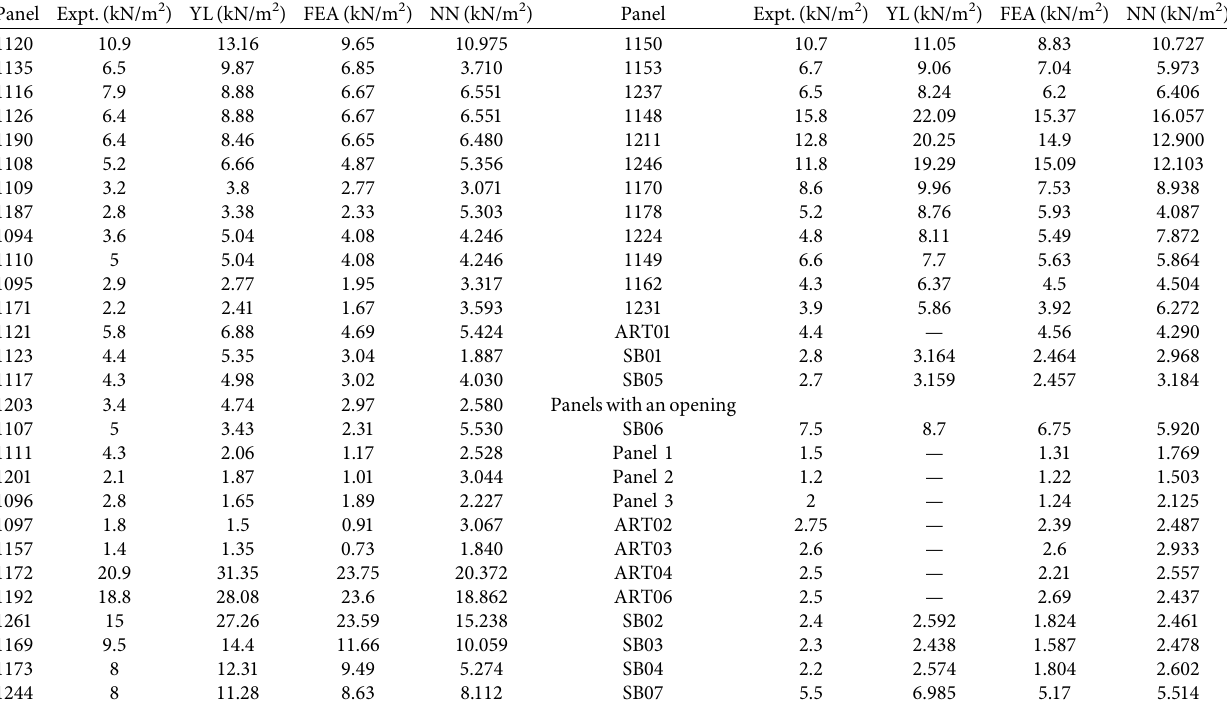
Table 4: Comparison between NN, FEA, and YL prediction with the experimental data